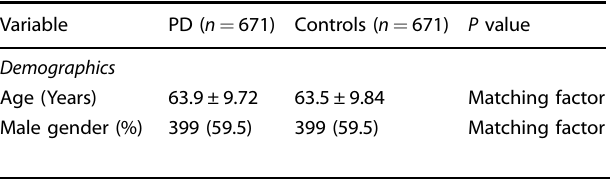
Table 1. Baseline characteristics of PD cases and controls.